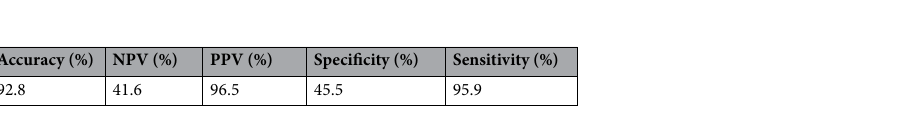
Table 2. Sensitivity, specificity, PPV, NPV and accuracy for clinical diagnosis. PPV positive predictive value, NPV negative predictive value.